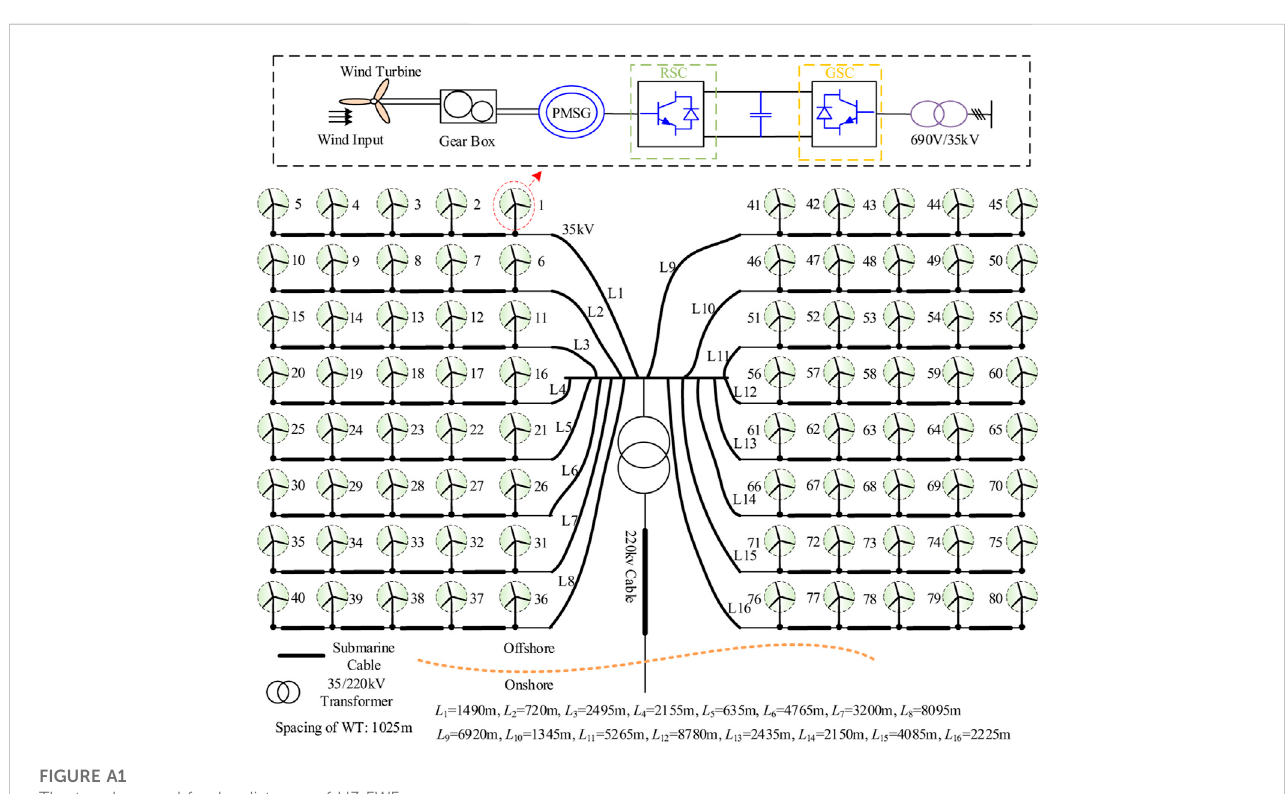
FIGURE A1 The topology and feeder distance of H3